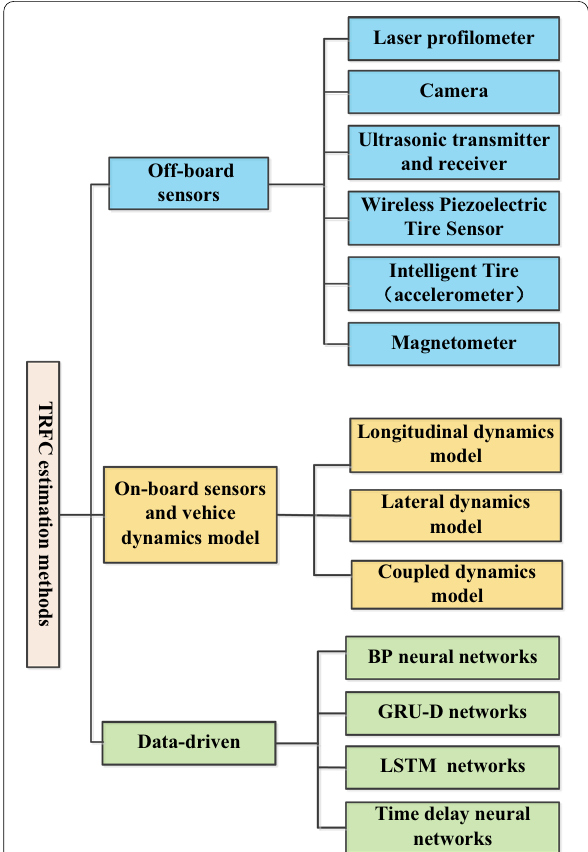
Figure 1 Classification of the TRFC estimation methods